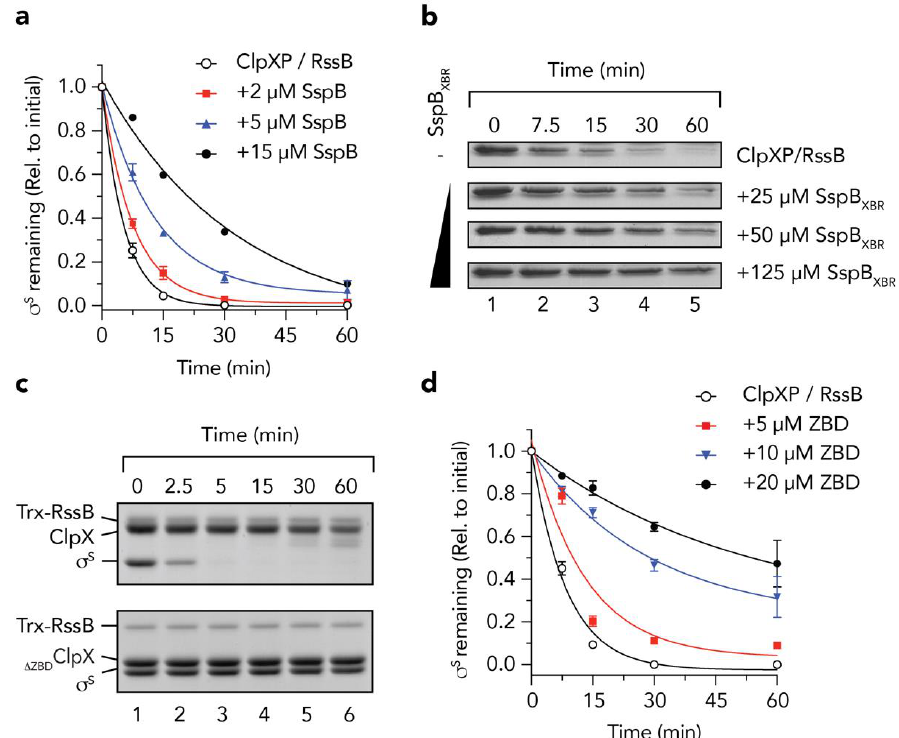
Figure 1. The zinc binding domain (ZBD) of ClpX is an essential platform for the RssB-mediated degradation of σ s . ( a ) The RssB-mediated turnover of σ s , by 1.2 µM ClpXP (open circles) is inhibited by the addition of 2 µM (red squares), 5 µM (blue triangles) and 15 µM (black circles) SspB. Three independent experiments were performed (n = 3), except for 15 µM SspB, where a single experiment was performed. Error bars represent the standards error of the mean (S.E.M.). ( b ) The RssB-mediated turnover of σ s , by ClpXP was monitored in the presence of increasing concentrations of SspB XBR . ( c ) The RssB-mediated degradation of σ s (by ClpP) was monitored in the presence of either ClpX (upper panel) or ClpX lacking the ZBD ( ∆ ZBD ClpX) (lower panel). ( d ) The RssB-mediated turnover of σ s , by 0.6 µM ClpXP (open circles) is inhibited by the addition of 5 µM (red squares), 10 µM (blue triangles) and 20 µM (black circles) ClpX ZBD (ZBD). Error bars represent standard error of the mean (S.E.M.) from 3 independent experiments (n = 3).